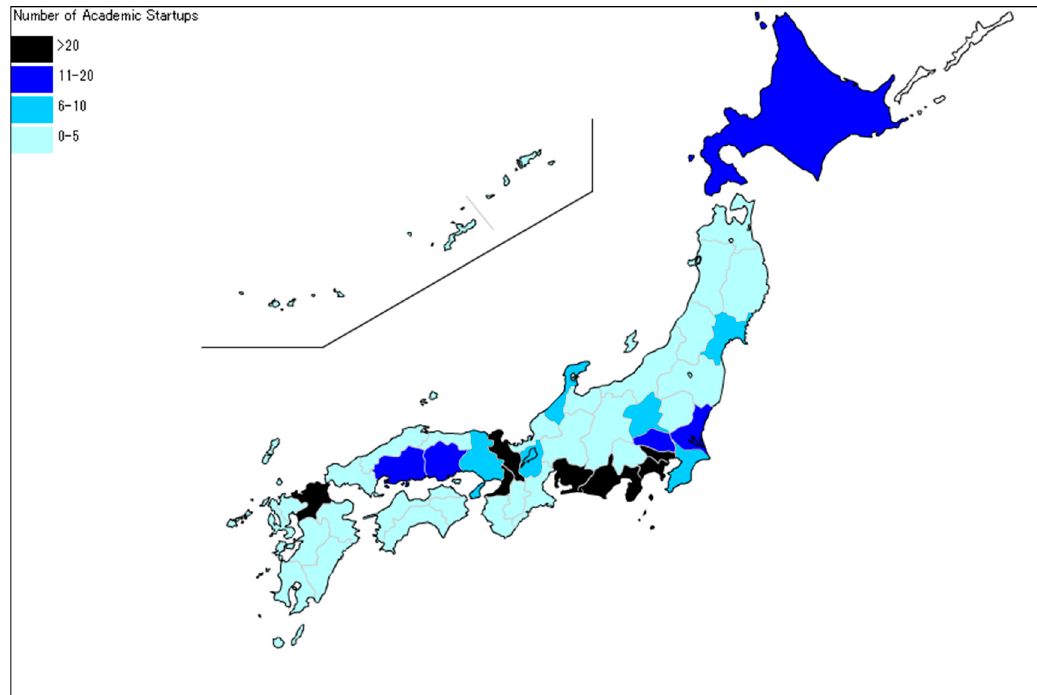
Figure 1. Distribution of sample ventures by prefecture.